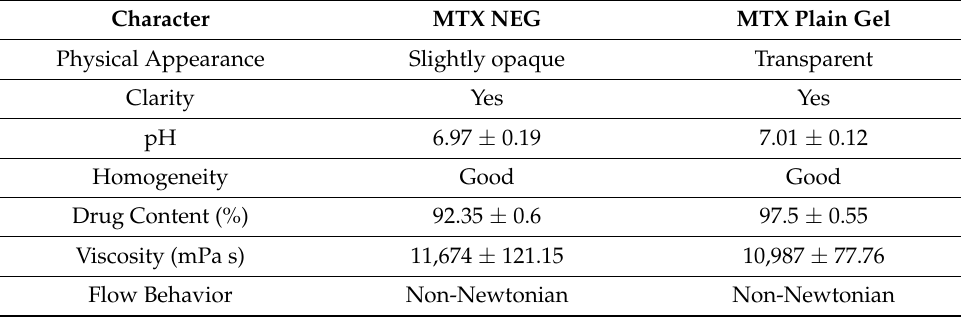
Table 3. Physicochemical and rheological parameters of